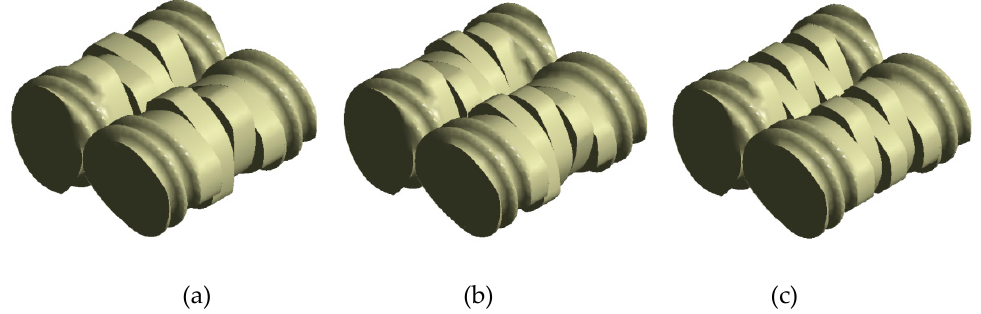
Figure 12. Geometries of screws with different stagger angles of kneading blocks: ( a ) S45; ( b ) S60; ( c ) S90.